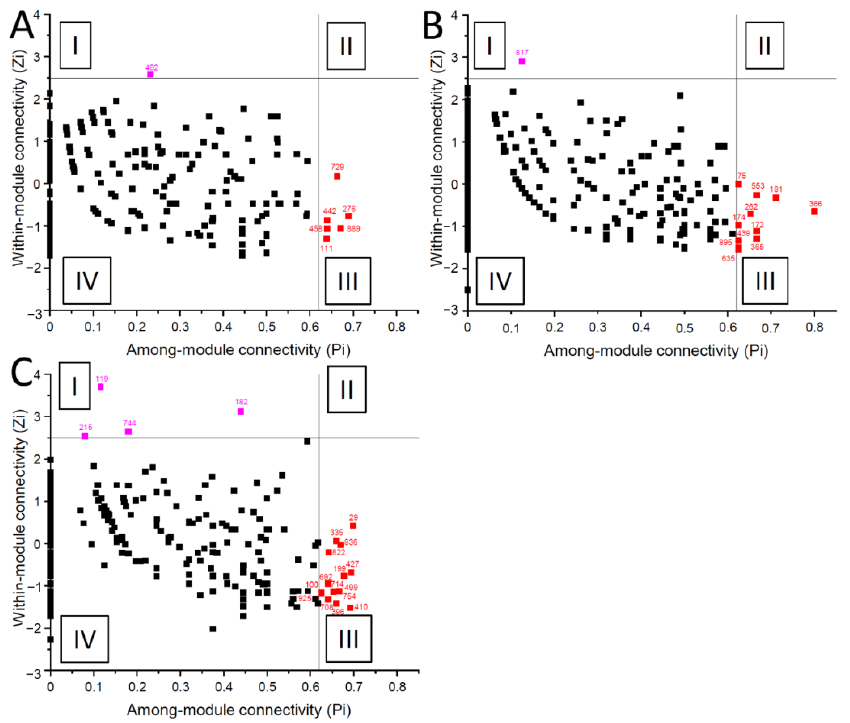
Figure 3. Network roles of each OTU of the bacterial skin microbiome retrieved from AD patients after daily synbiotic ( A ), prebiotic ( B ) or placebo bath treatment ( C ). Each OTU was categorized into module hubs (I), network hubs (II) connectors (III) or peripherals (IV) according to Olesen et al. (2007) [29]. OTU details of I-III can be found in Table 2 and OTU details of IV can be found in Supplementary Table S2.